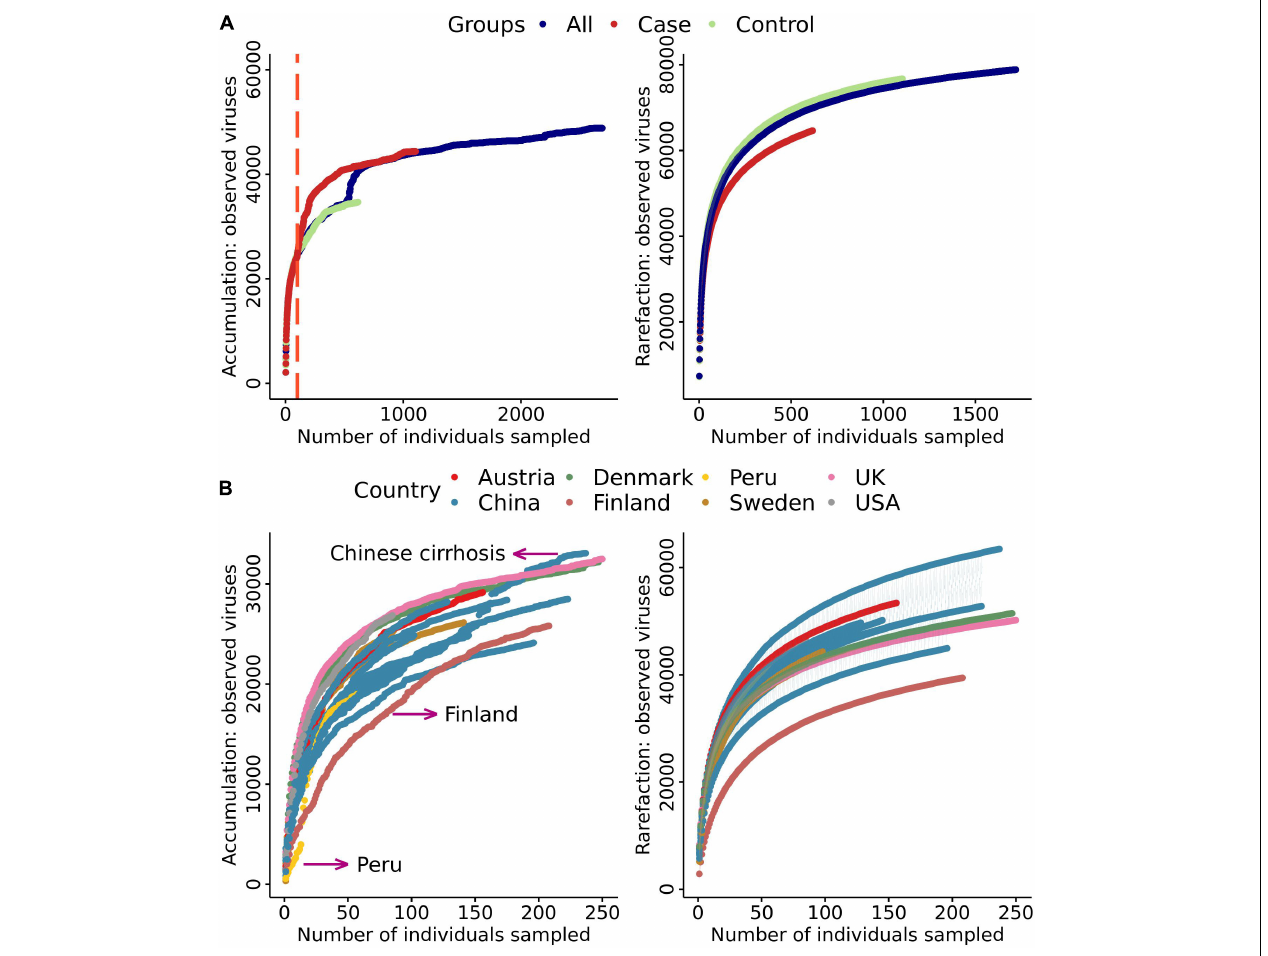
FIGURE 2 | Cumulative curves of the number of virus species against the number of samples. (A) Cumulative and rarefaction curves of cases, controls, and all samples. Only samples from studies with a case–control design were included. (B) Cumulative and rarefaction curves of sample data divided into seven